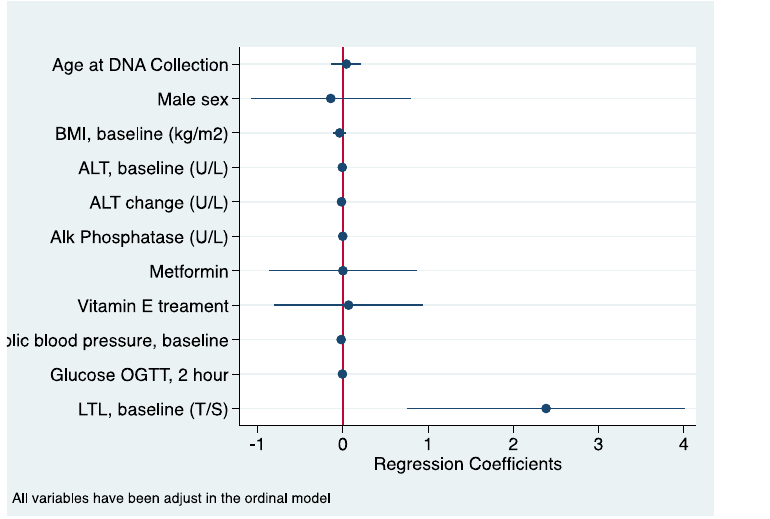
Figure 2. Predictors of lobular worsening at 96